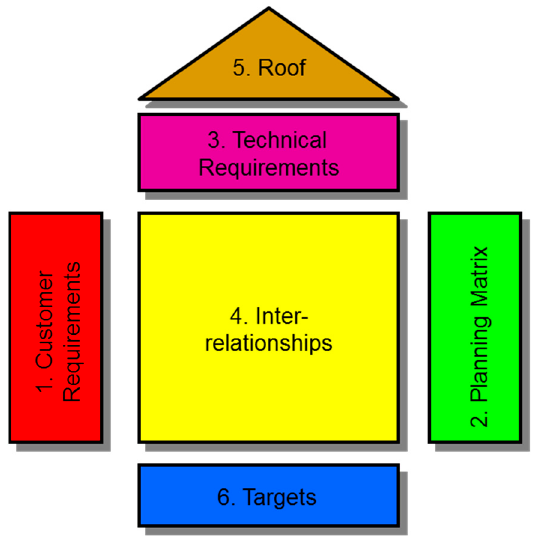
Figure 2. Framework of a typical QFD matrix.